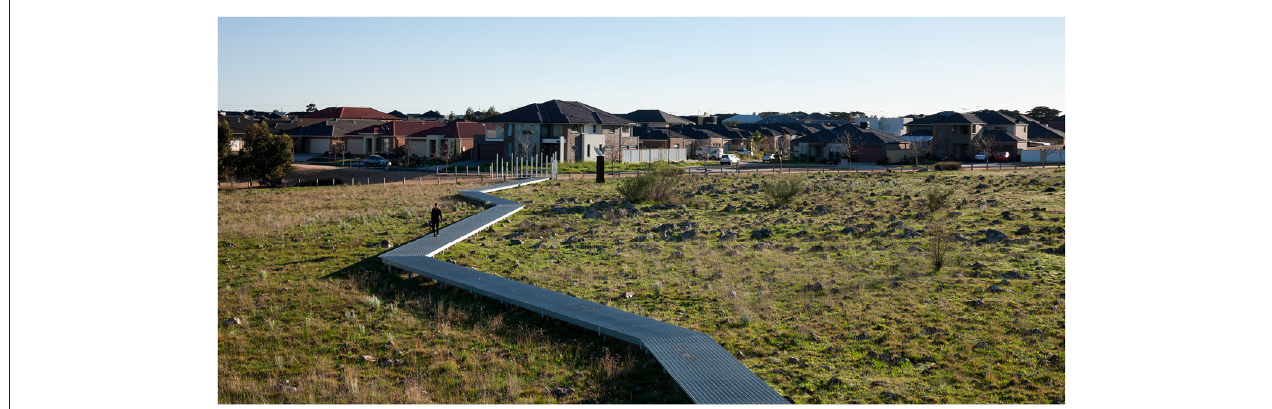
FIGURE 4 | Well-integrated. Photo taken from a grassland lookout designed to encourage users into the grassland, while encouraging them to stay on a set path to minimize damage from trampling. The entrance is signaled by public art work, housing faces the grassland and the road is used as a firebreak. Image: © Diana Snape.